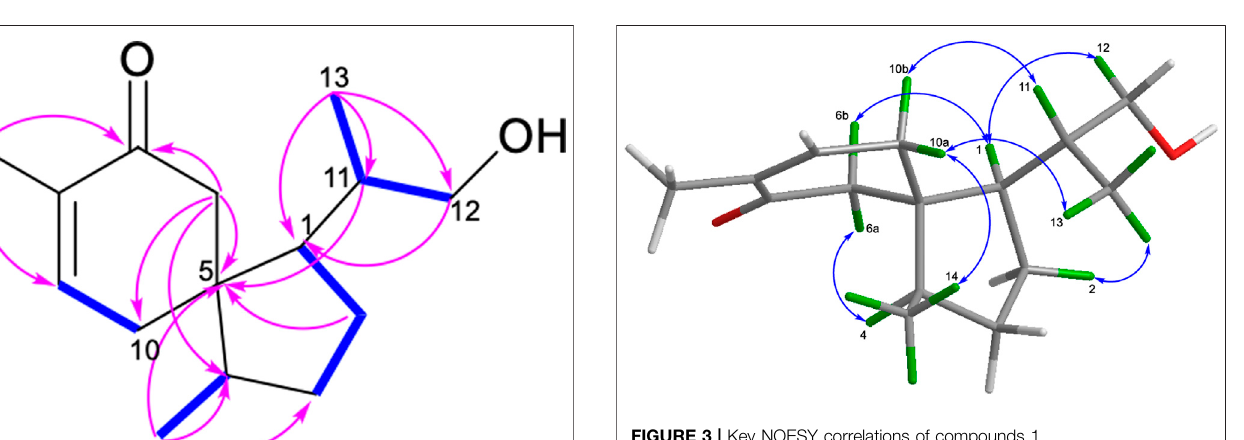
FIGURE 3 | Key NOESY correlations of compounds